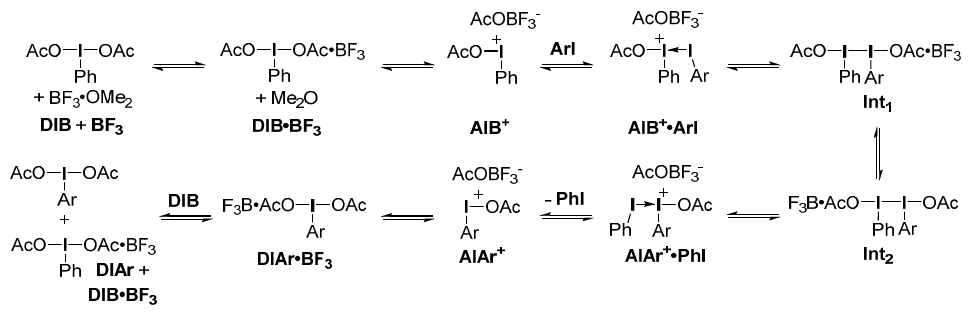
Scheme 5. Reaction mechanism evaluated using DFT calculations (Ar = Ph for simplicity).